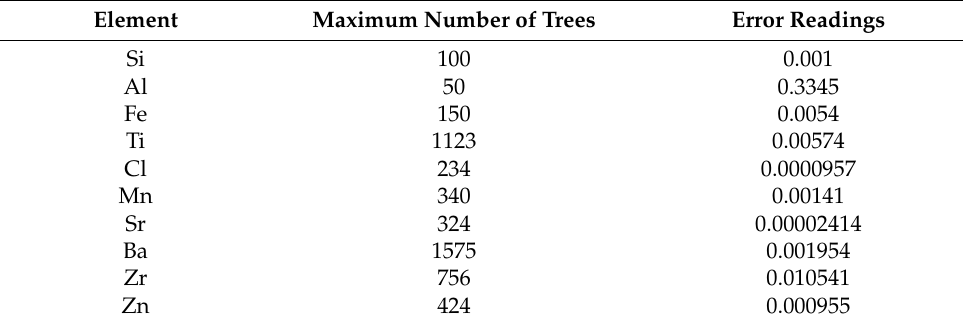
Table 3. Maximum values of the number of trees and their error readings of